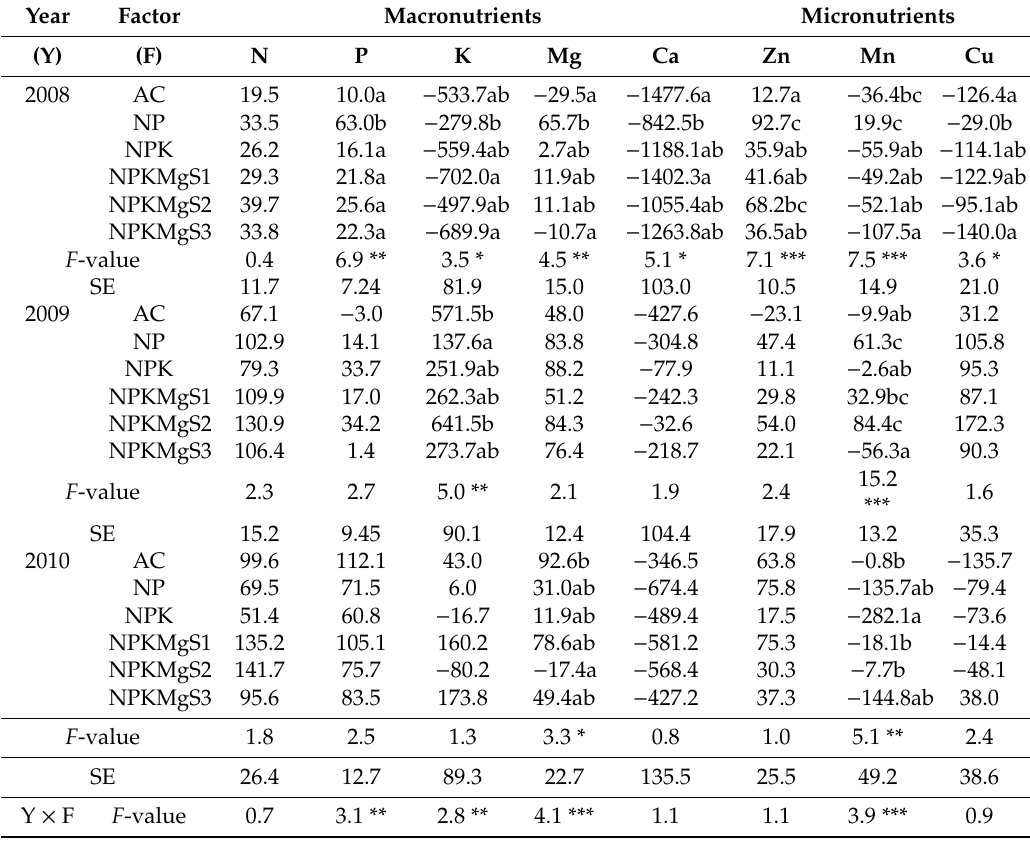
Table A6. Reutilization coe ffi cients of pre-flowering nutrient resources in seeds,